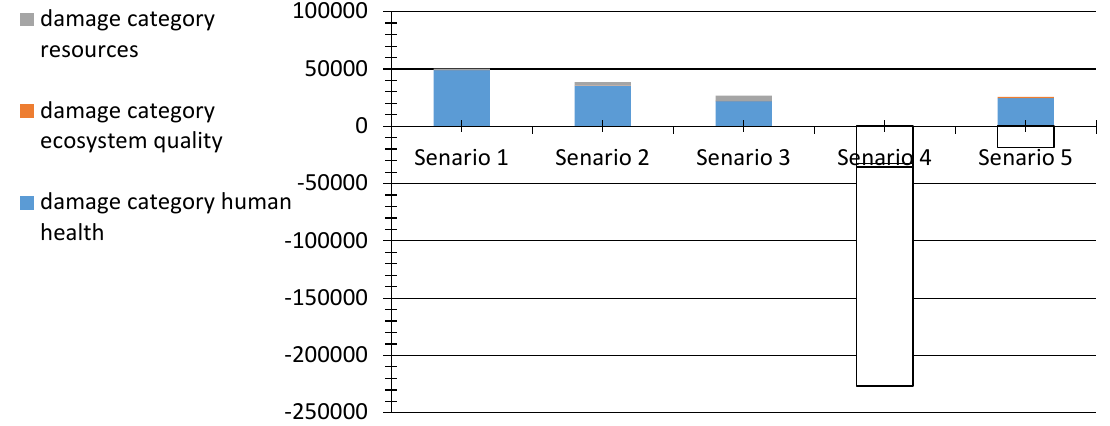
Figure 2. Weighted impact category values